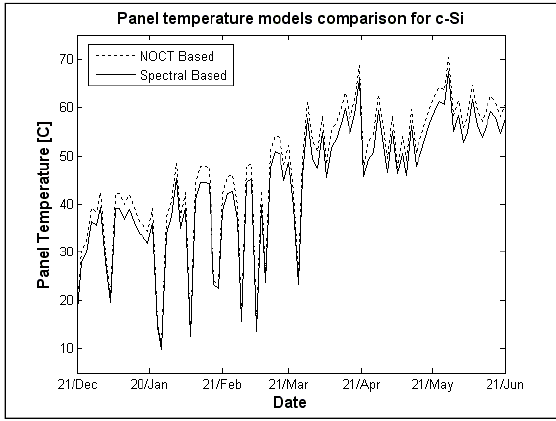
Figure 4. Variation of c-Si module temperature at noon on the 21 st of month, Dec.-June.